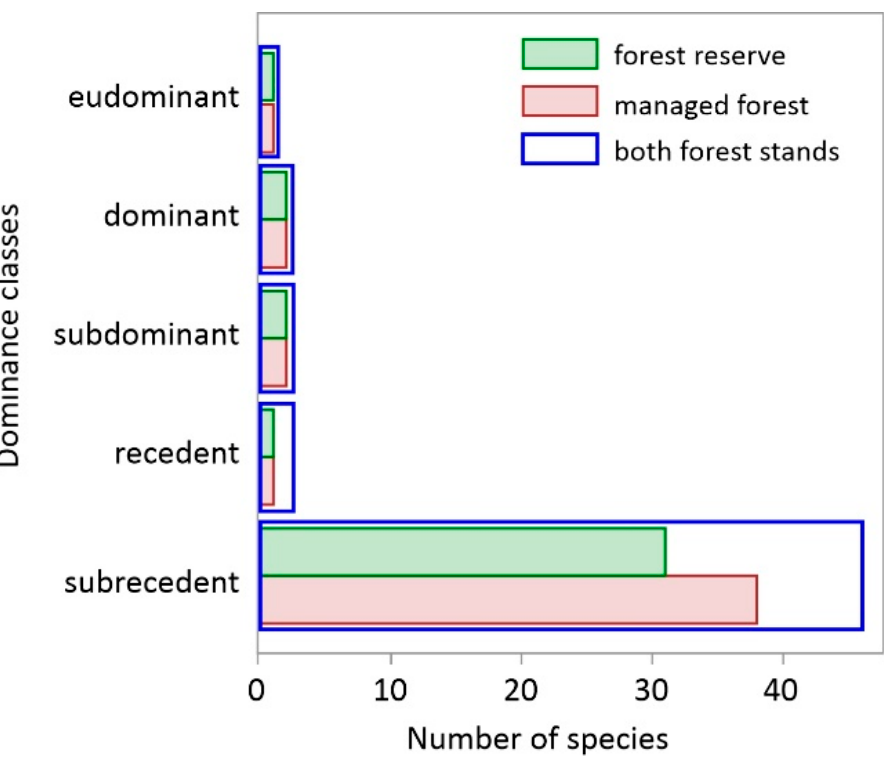
Figure 5. Distribution of the number of beetle species caught in pitfall traps by dominance classes. Among the 29 common species identified in the two stands, 17 species fell into similar constancy classes (7 euconstant species, 1 accessory species, and 9 accidental